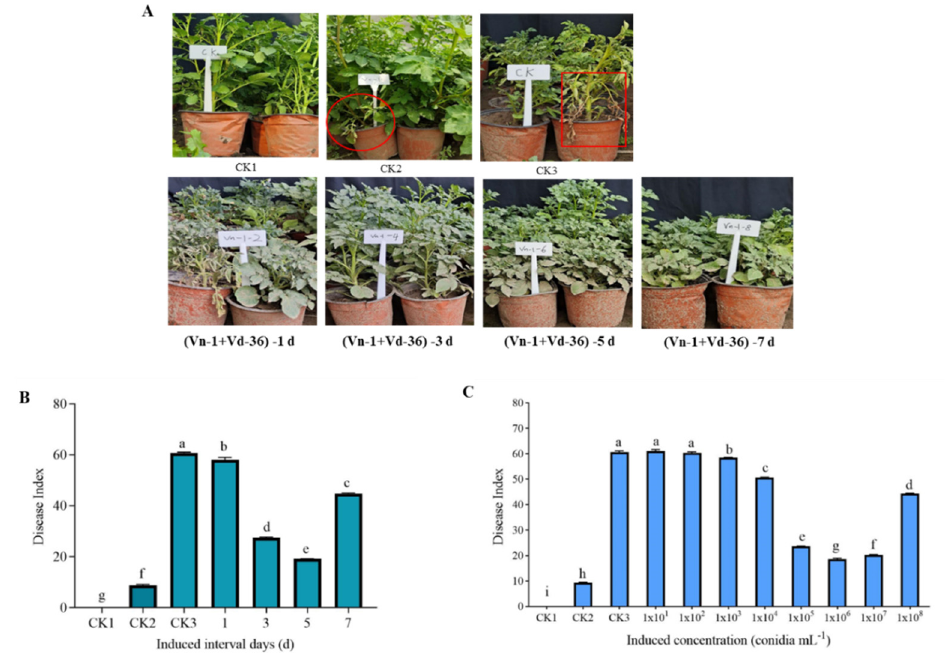
Figure 1. Less-virulent isolate Gibellulopsis nigrescens Vn-1 enhances potato resistance to Verticillium wilt caused by Verticillium dahliae . Disease symptoms and disease indexes of living plants assayed after 25 d in the pot experiment treated with G. nigrescens Vn-1 at different interval days and different conidial suspension concentrations of G. nigrescens Vn-1, first at 5 d post-inoculation before inoculation with V. dahliae Vd-36: ( A ) disease symptoms; ( B ) disease indexes of potato Verticillium wilt at different induced interval days; ( C ) disease indexes of potato Verticillium wilt at different induced conidial suspension concentrations (from 1 × 10 1 to 1 × 10 8 conidia mL − 1 ) of G. nigrescens Vn-1. CK1 was inoculated with sterile water, and only less-virulent isolate G. nigrescens and strong-virulent isolate V. dahliae Vd-36 were used in CK2 and CK3, respectively, as controls. Significant differences are indicated by letters above bars (Tukey’s multiple range test, p < 0.05).